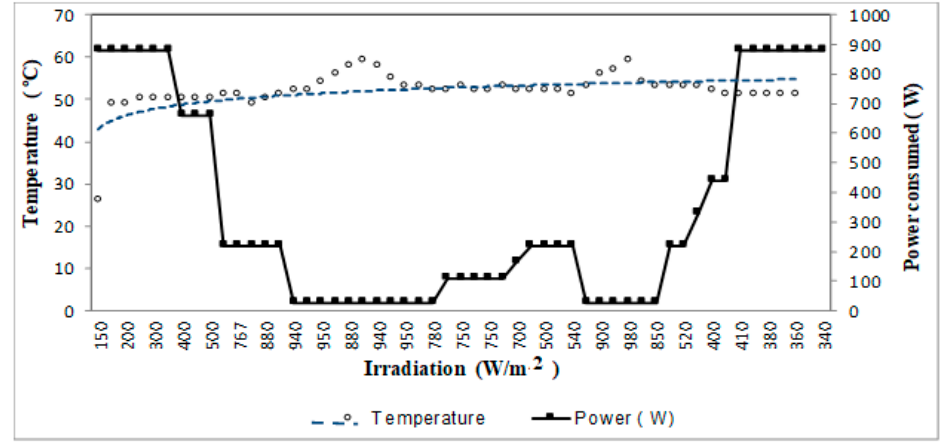
Figure 10. Hybrid dryer at work using solar energy, aerothermal, and an auxiliary system (electrical